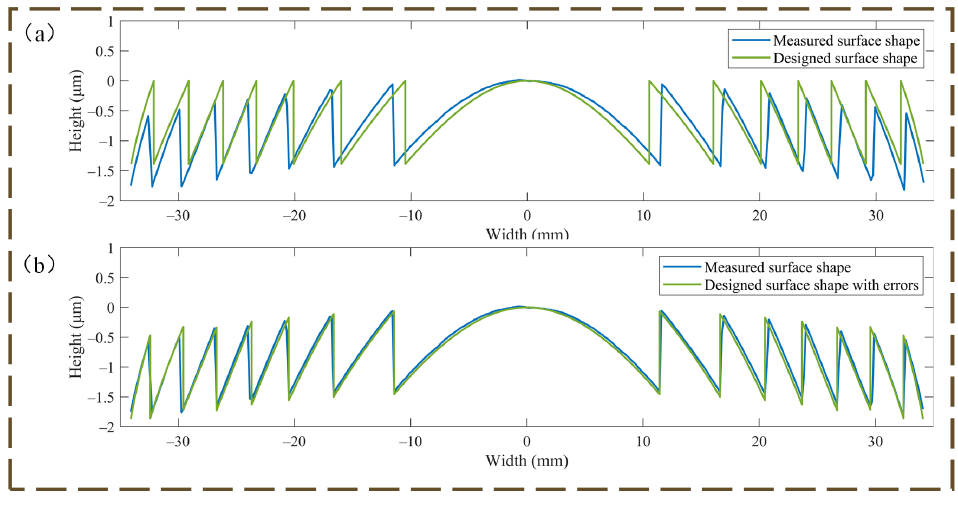
Figure 7. ( a ) Comparison of the measured and designed surface shapes of FODS; ( b ) Comparing the actual measured surface shape and combining potential errors, the data are more consistent. Errors were present in both the zone’s height and breadth. Due to the real processing, the width error dropped progressively from the inside to the exterior, but the height error grew gradually. The highest and average width error values are 0.927 mm and 0.5229 mm, while the greatest and average height error values are 0.7652 μ m and 0.3533 μ m, respec ‐ tively.